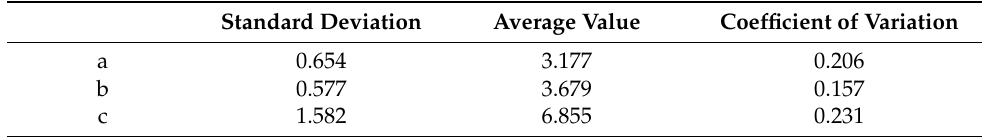
Figure 12. The velocity flow field distribution of different rice distributor CFD simulation with type B. ( a ) 8 m/s inlet velocity; ( b ) 16 m/s inlet velocity; ( c ) 24 m/s inlet velocity. Table 3. The variability uniformity experiment of left five tubes.